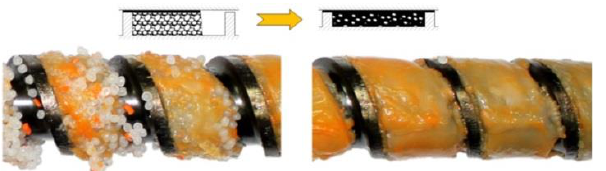
Figure 3. Melting mechanism at starve fed single screw extrusion of polypropylene [8].